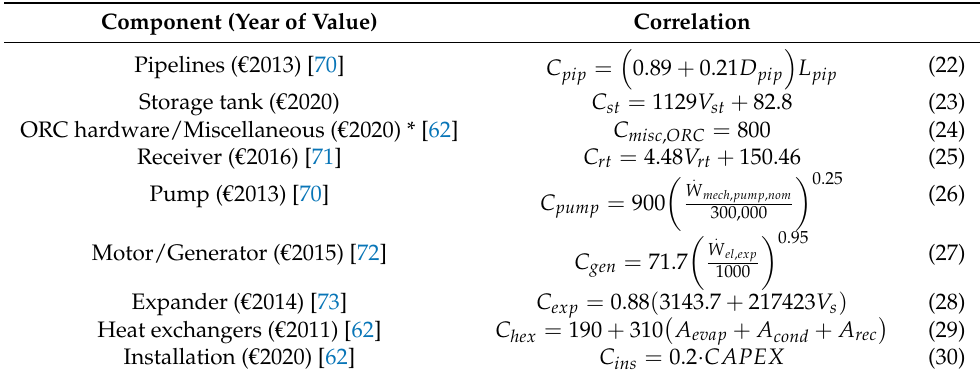
Table 7. Cost correlations for system’s components (all correlations are adapted to € 2019 equivalent values).